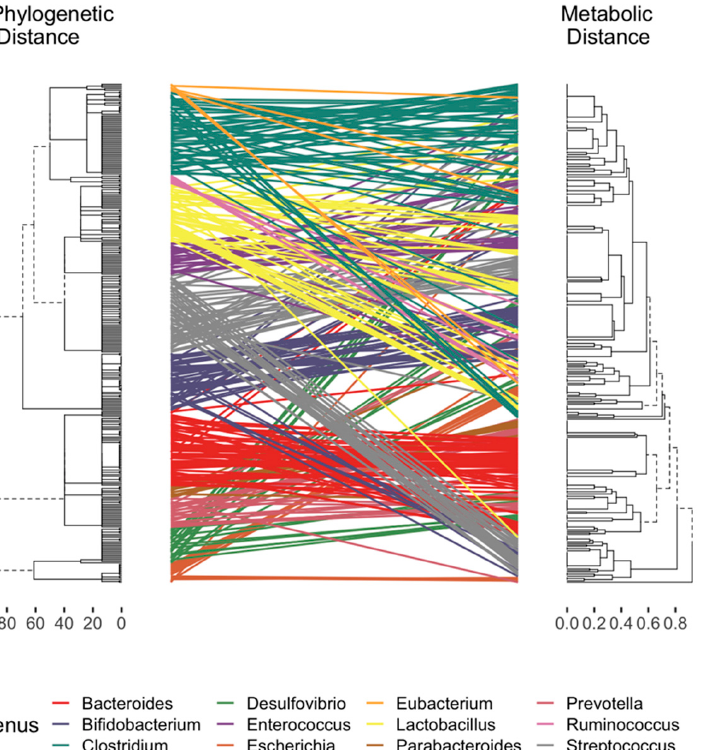
Figure 4. Tanglegram between the dendrograms of phylogenetic and metabolic distance. The phylogenetic dendrogram generated by hierarchical clustering with complete linkage of the taxonomy rank of maximum likelihood tree. The dendrogram of metabolic distance was calculated on the basis of the presence or absence of tryptophan metabolite production. Lines are colored by genus and connect the same microbes.